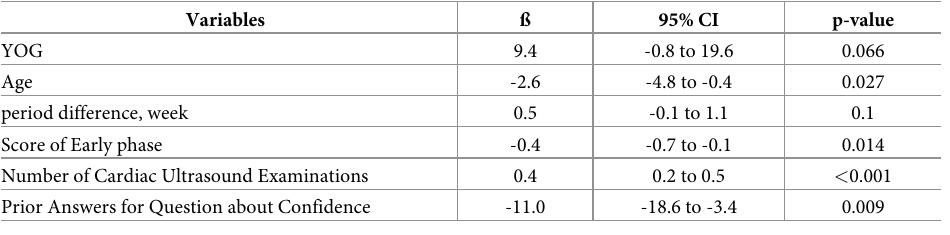
Table 6. Multivariable linear regression analysis for performance improvement in bedside cardiac